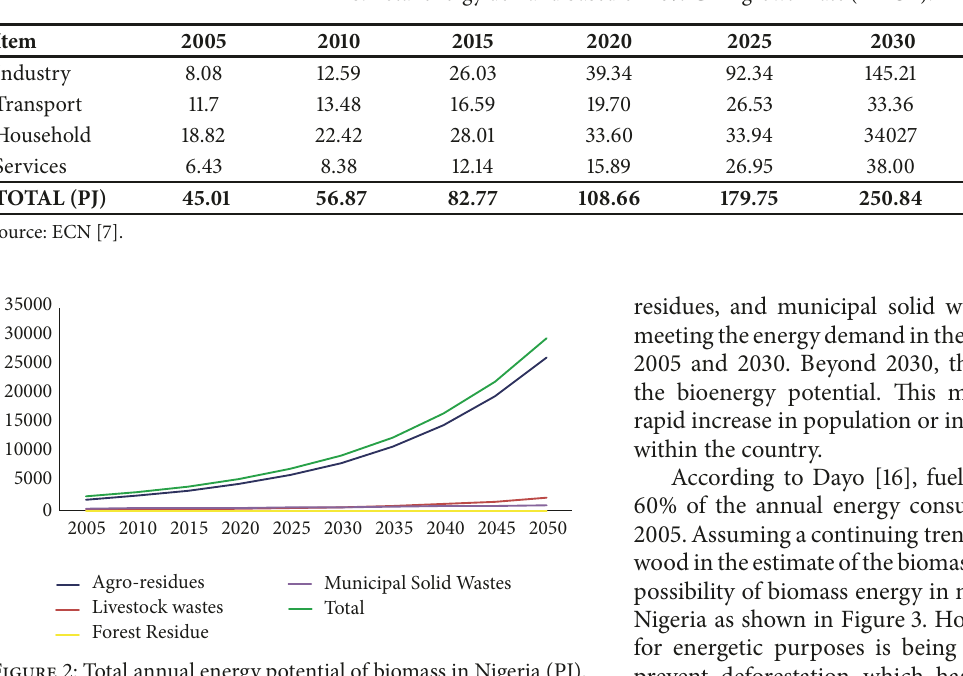
Figure 2: Total annual energy potential of biomass in Nigeria (PJ).